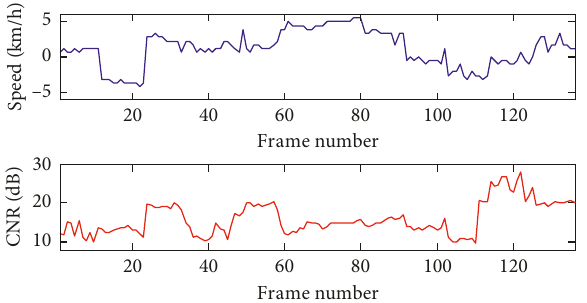
Figure 13: Results of CNR and relative Doppler speed in Test 1.